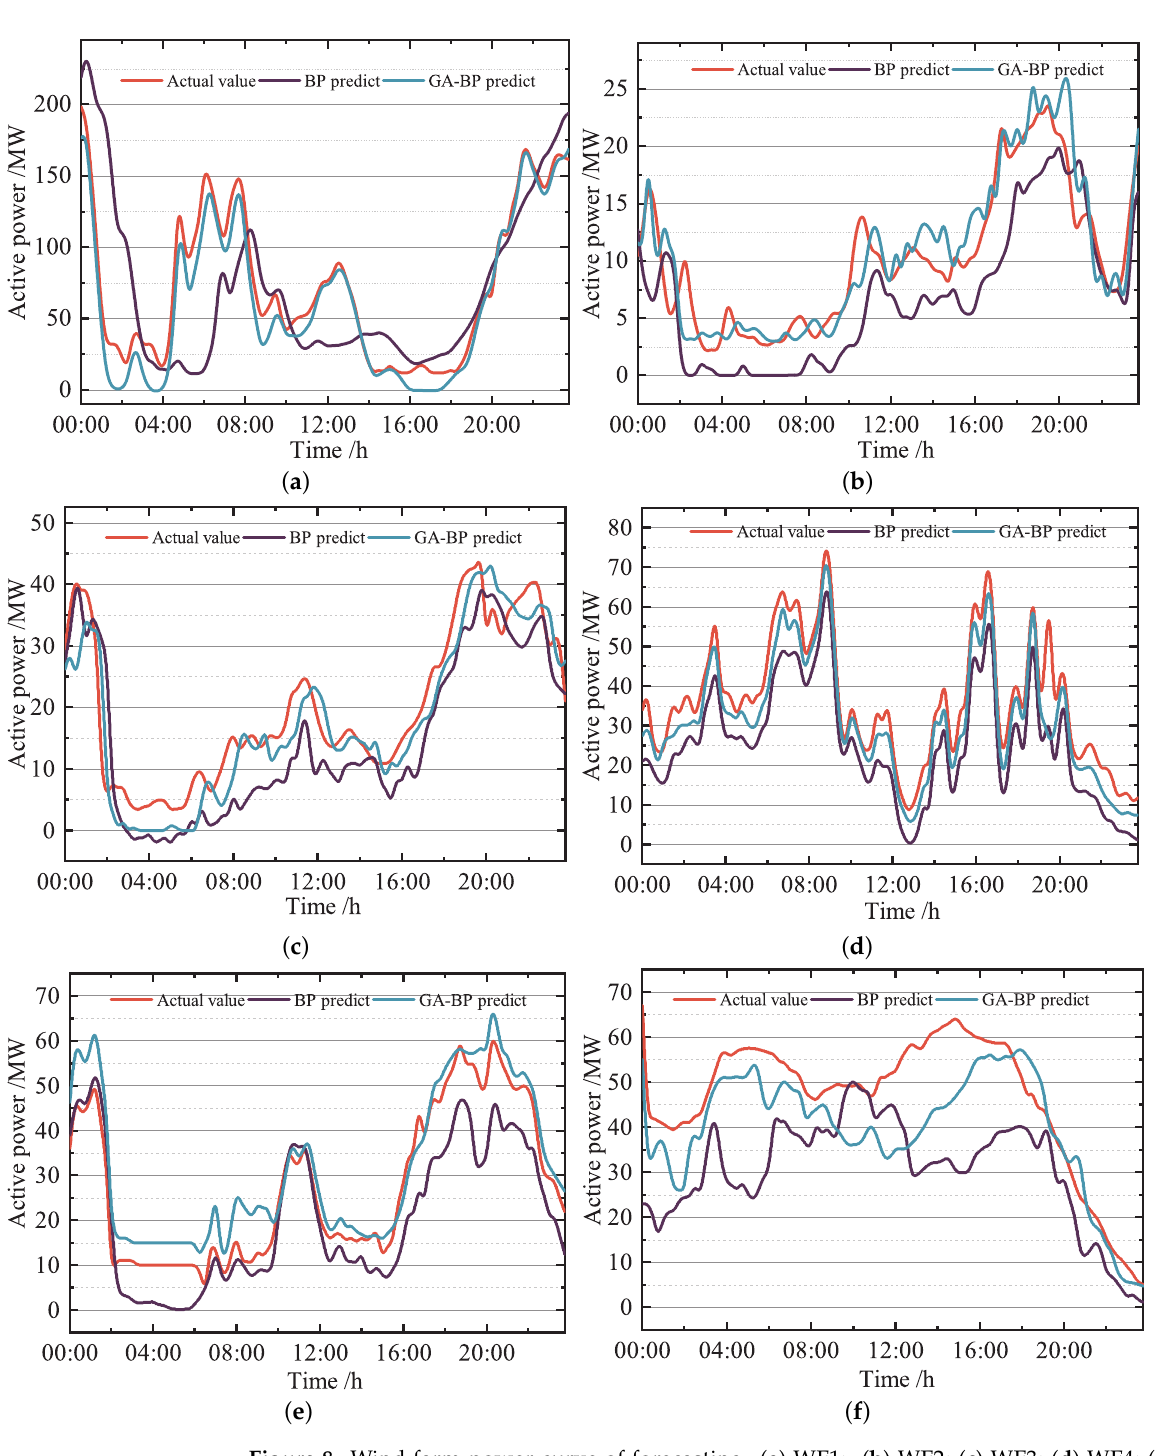
Figure 8. Wind farm power curve of forecasting. ( a ) WF1; ( b ) WF2; ( c ) WF3; ( d ) WF4; ( e ) WF5; ( f )